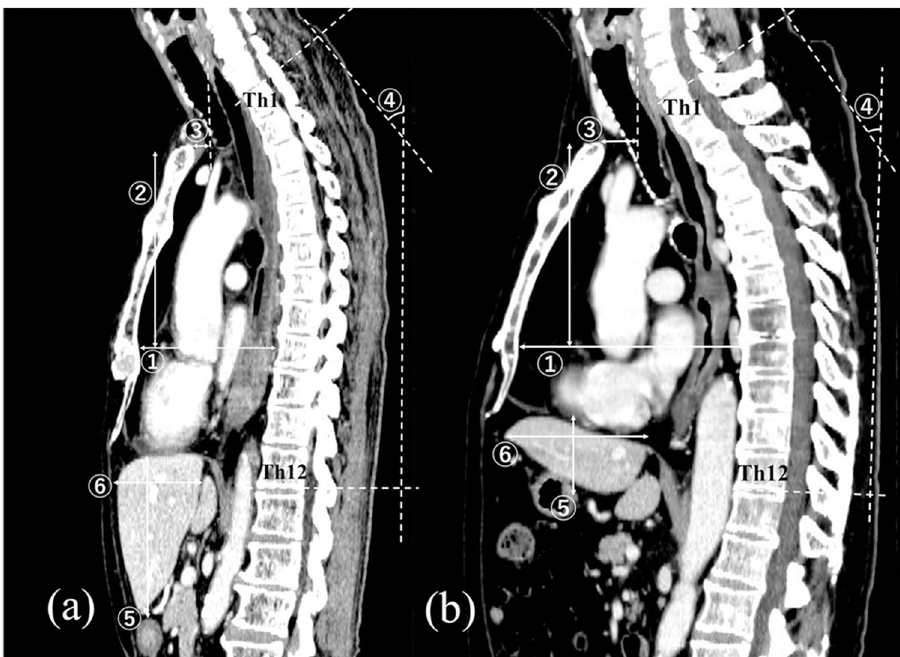
Fig 2. Measurement methods for factors contributing to the length of the reconstruction route. (a) Thin thorax: BMI of 17.9 kg/m 2 , thoracic thickness of 9.7 cm, and RS–ES length of -0.7 cm. (b) Thick thorax: BMI of 26.3 kg/m 2 , thoracic thickness of 14.3 cm, and RS–ES length of 1.8 cm. Each point was measured in the mid-sagittal central plane. ① The thickness of the thorax was measured from the lower border of the body of the sternum to the vertebral body. ② The height of the thorax was measured from the upper border of the jugular notch to the lower border of the body of the sternum. ③ The depth of the thoracic inlet space was measured from the upper border of the jugular notch to the lower border of the cricoid cartilage. ④ The thoracic curve was measured at the angle of the extended intersection between Th1 upper and Th12 lower borders of the vertebral body. ⑤ The height of the liver was measured at the cranial–caudal distance. ⑥ The thickness of the liver was measured at the anterior–posterior distance.